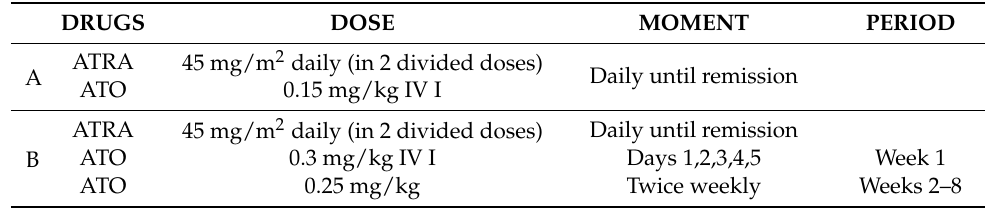
Table 1. Recommended therapy for low-risk APL